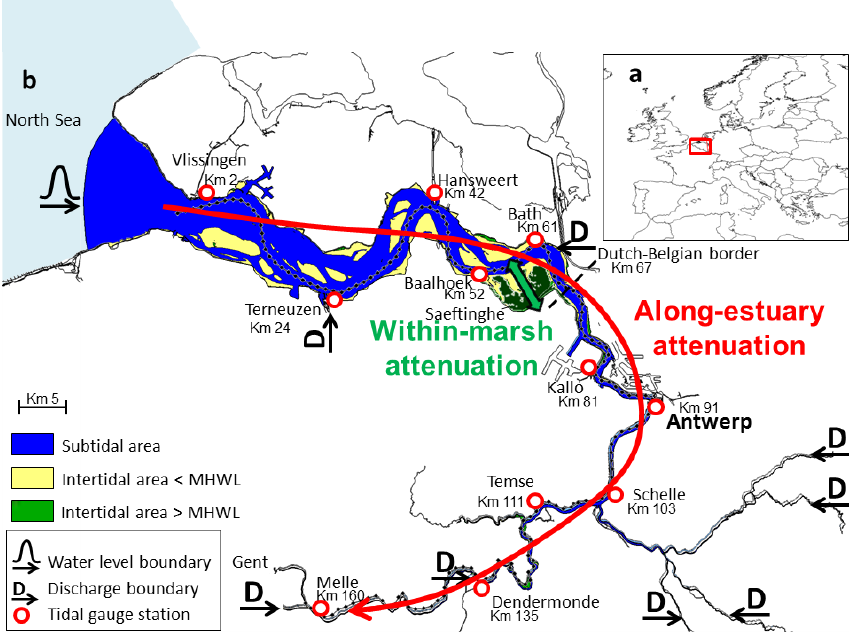
Figure 1. (a) Location of study area within Western Europe; (b) detail of location of the model domain, boundaries and main tidal gauge stations. Difference between within-wetland attenuation and along-estuary attenuation. Km indication along main estuarine